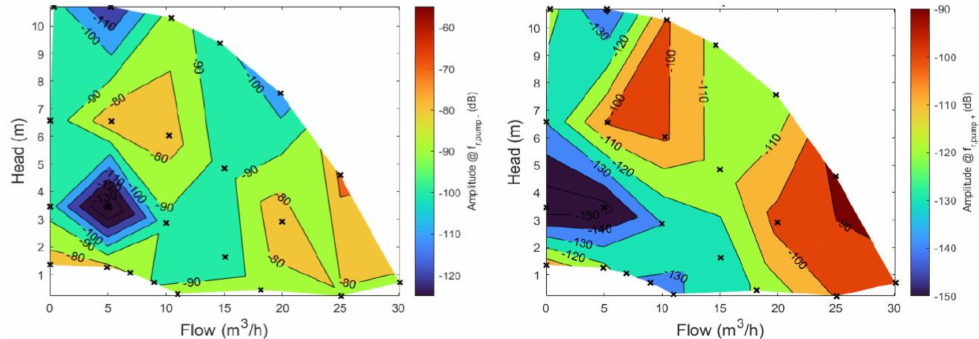
Figure 10. LoPoFIA for the fault indicators f r , pump − and f r , pump + for a pump with one clogged impeller channel.